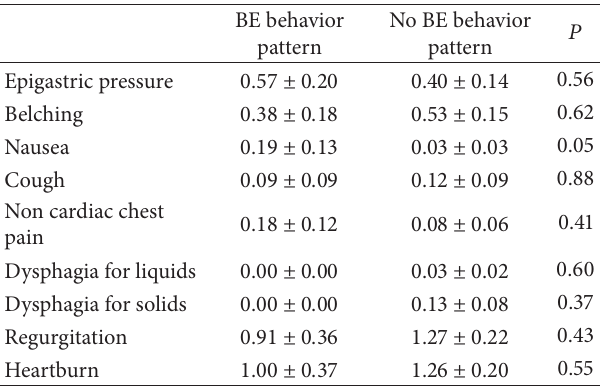
Table 2: Shows the frequency intensity scores of the studied GI symptoms such as epigastric pressure, belching, nausea, cough, non cardiac chest pain, dysphagia for liquids, dysphagia for solids, regurgitation, and heartburn in Obese Patients with and without BE behavior pattern data were expressed as Mean ± SE.